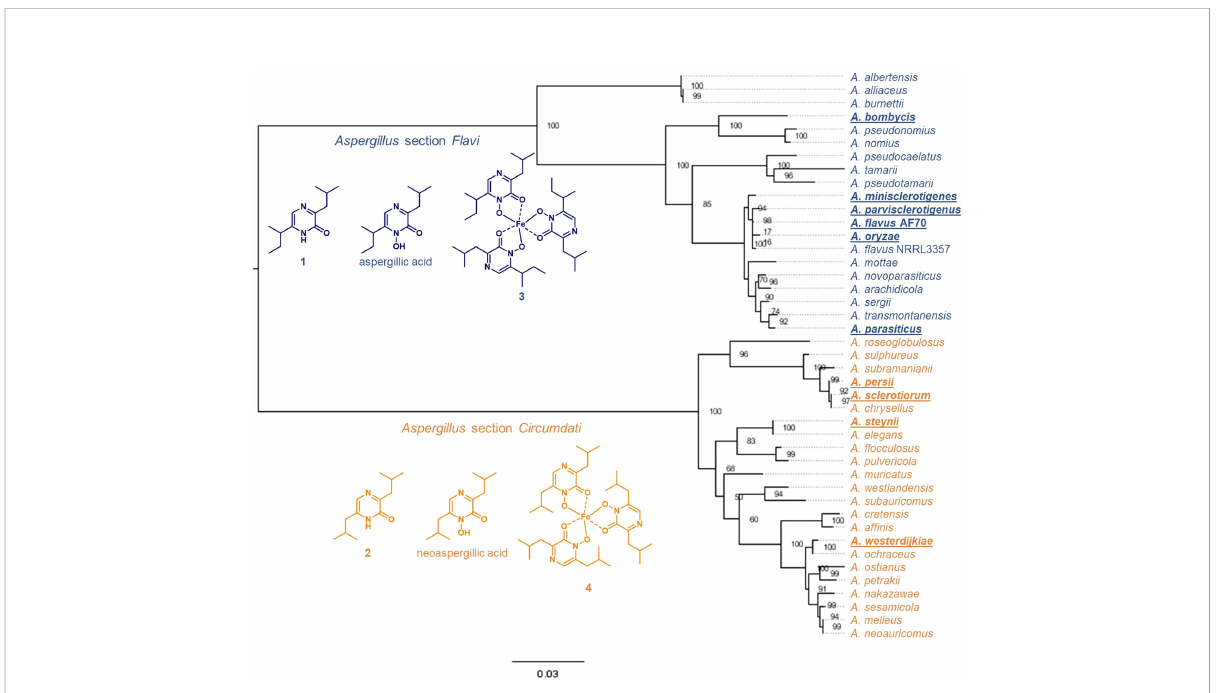
FIGURE 2 Sequence homology of AsaC in Aspergillus section Flavi is distinct from section Circumdati species. Phylogenetic tree of AsaC NRPS-like orthologs in Aspergillus section Flavi (blue) and Circumdati (orange) species. Chemical con fi rmation of the substituted pyrazinones and their derivatives produced by these species are in underlined bold font (Lebar et al., 2019). Blue: predominantly deoxyaspergillic acid-derived ( 1 ), including aspergillic acid and ferriaspergillin ( 3 ); orange: exclusively fl avacol-derived ( 2 ), including neoaspergillic acid and ferrineoaspergillin ( 4 ). The node values represent the branch bootstrap values using the ultrafast bootstrap